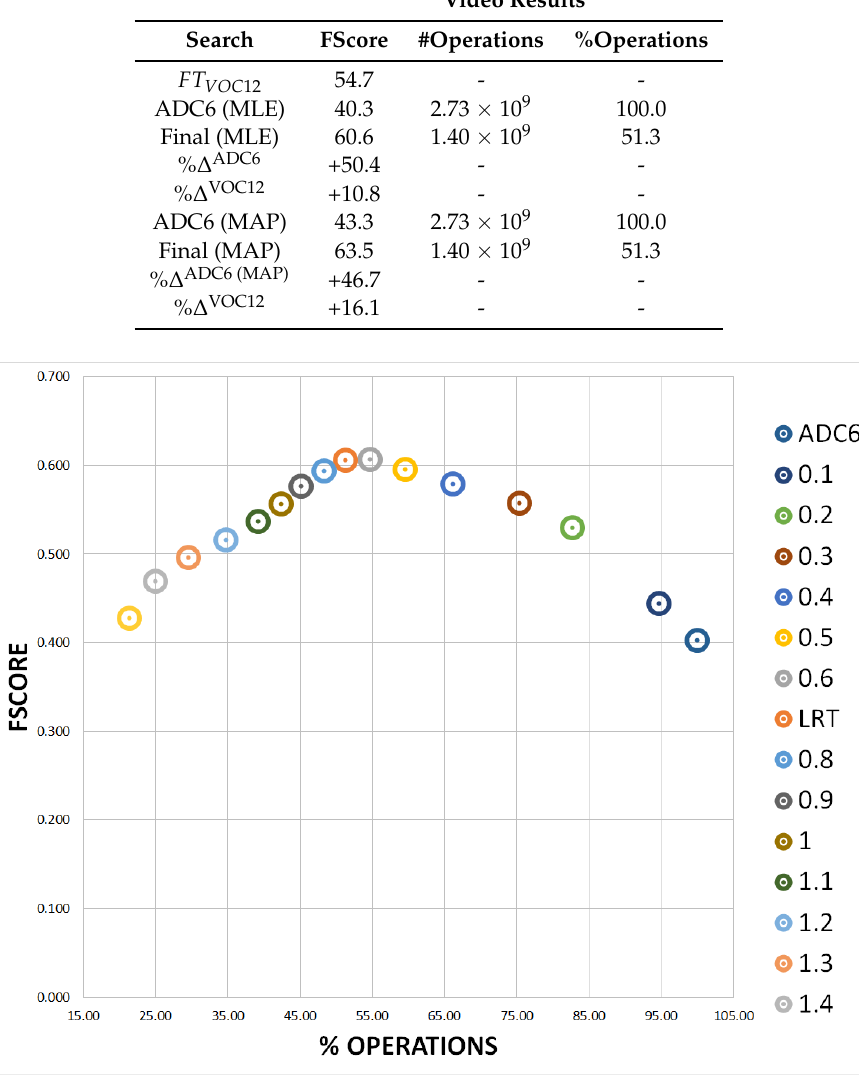
Figure 12. Comparative video analysis results with different coarse adaptation configurations, absence/presence of people classification decision, from entropy E = 0 to 1.5. Global FScore results for each video versus computational cost in terms of percentage of